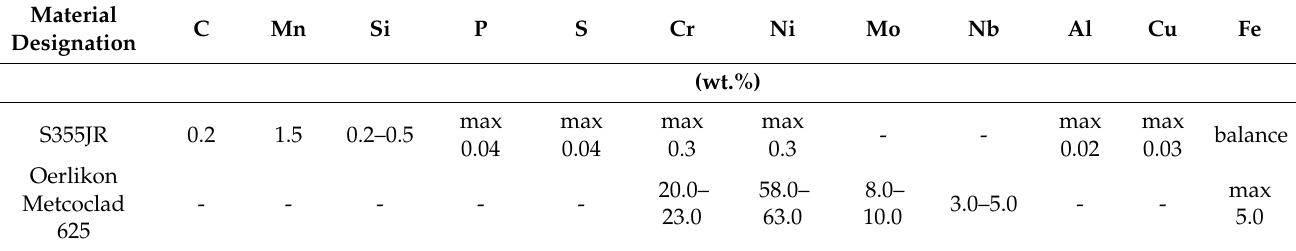
Table 1. Chemical composition of S355JR base material and Metcoclad 625